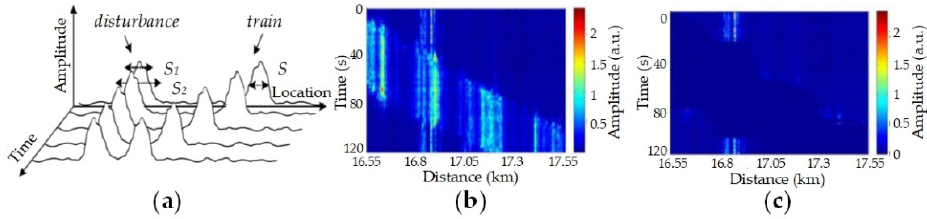
Figure 22. ( a ) Theoretical model for MDCA; Waterfall patterns of ( b ) raw signals and ( c ) MDCA-processed signals, with running train and disturbances. Reproduced with permission from our previous paper [91].